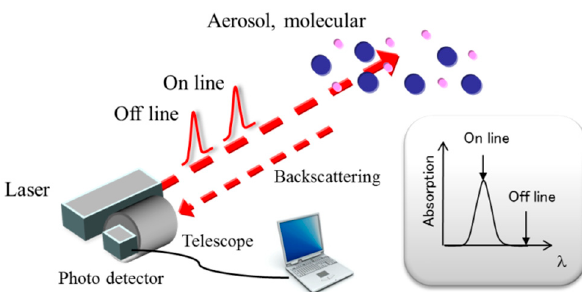
Figure 1. Schematic illustration of the differential absorption Lidar (DIAL) system.